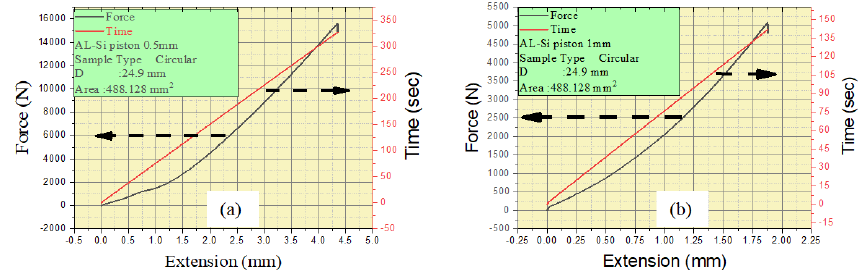
Figure 18: The relation between extension force, and time (a) piston substrate 500 µ m coat and (b) piston substrate 1000 µ m coat Table 3: Results of bonding strength testing